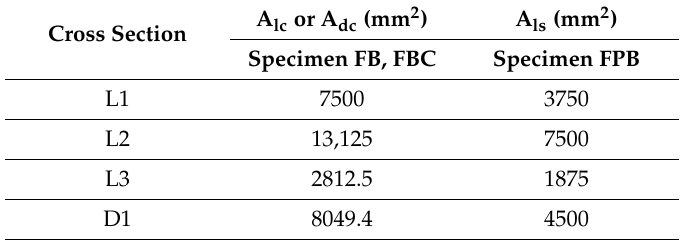
Table 1. Cross-section of each element for idealized analysis model.